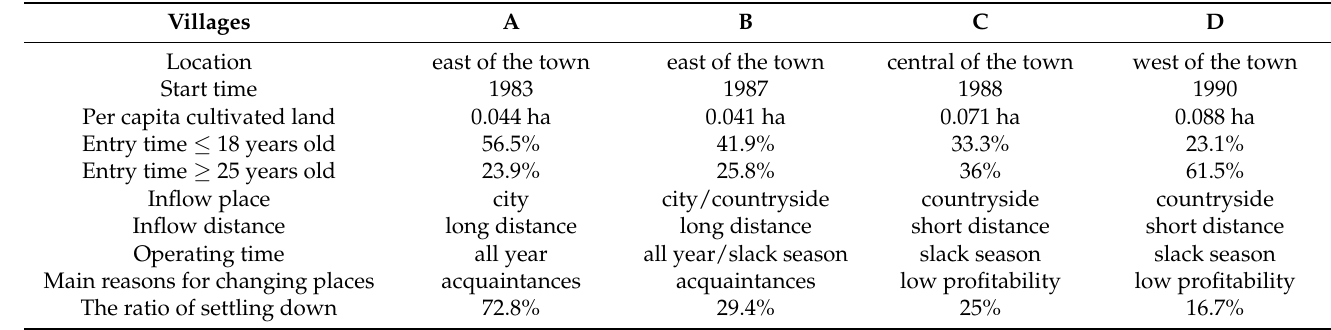
Table 1. The locations of the villages and the differences in mobility